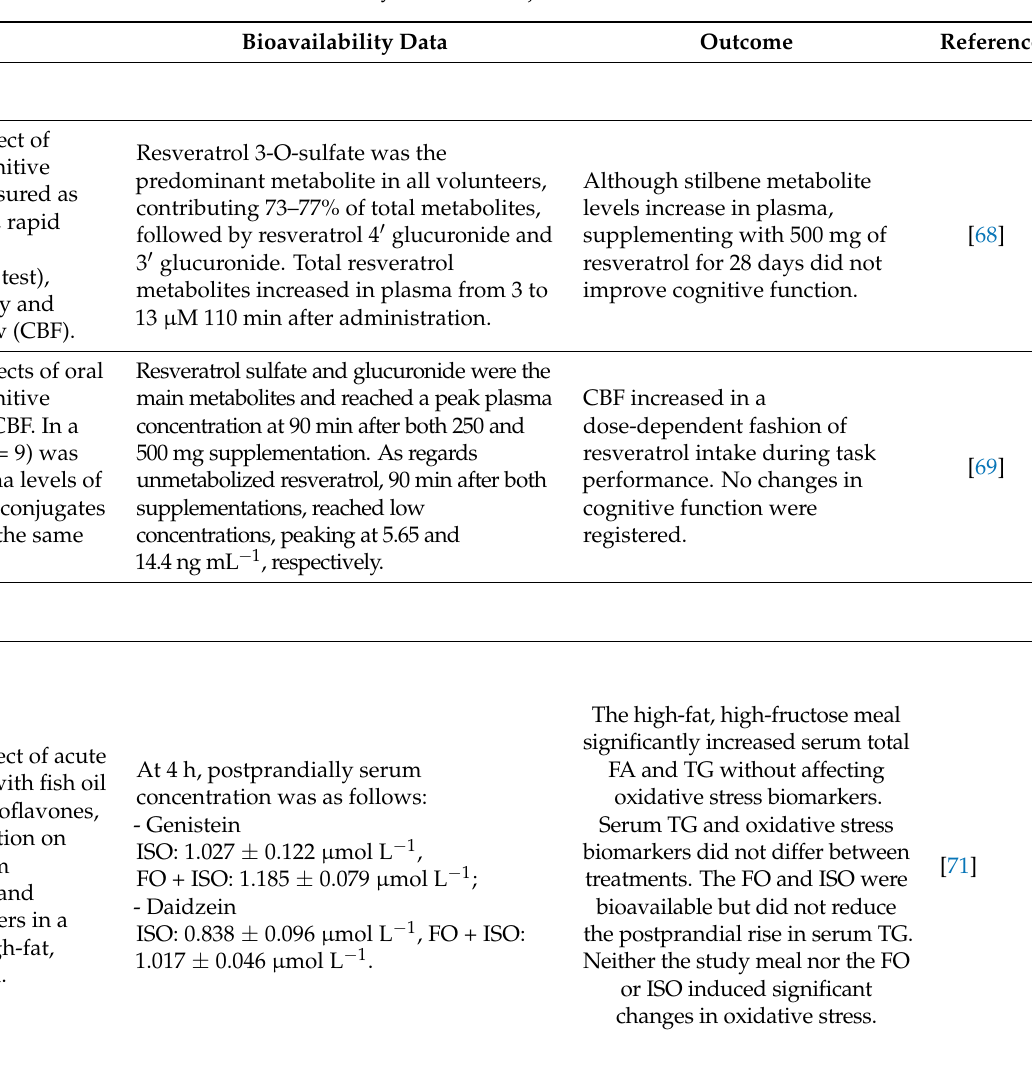
Table 5. Stilbenes’, isoflavones’, and flavanones’ beneficial effects and bioavailability in human